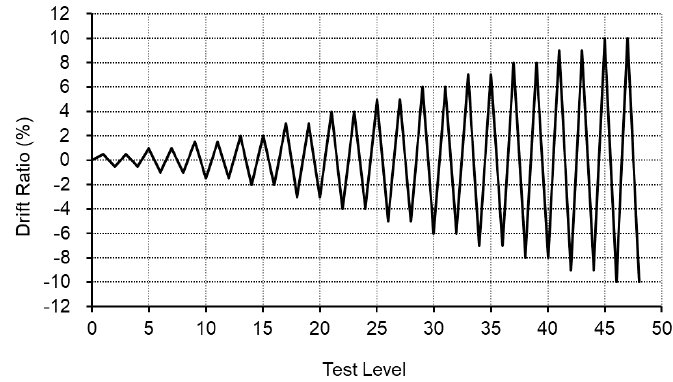
Figure 20. Loading plan.